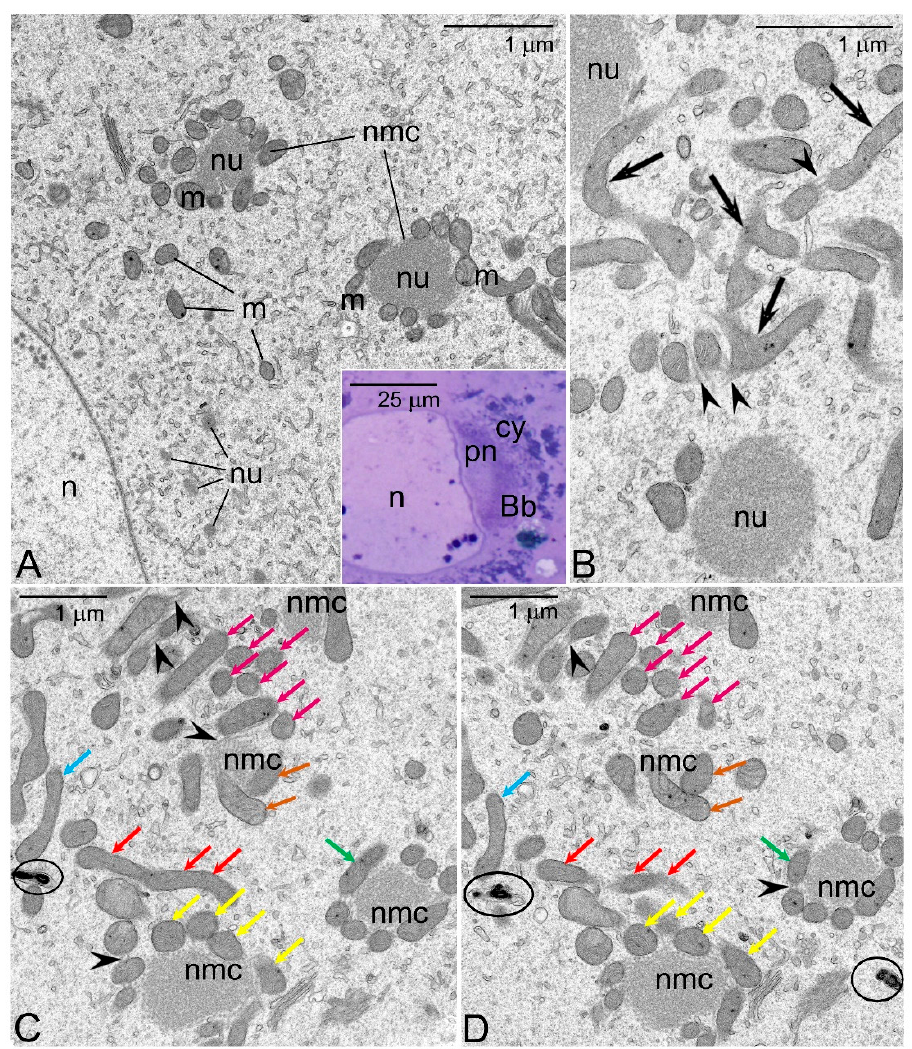
Figure 2. Balbiani body (Bb) of Metrioptera brachyptera . ( A ) and ( insert ) The Bb consists of two zones: perinuclear (pn) and cytoplasmic (cy). Note mitochondria (m), nuage accumulations (nu) and nuage/mitochondria complexes (nmc). Oocyte nucleus (n). TEM; ( insert ) semi-thin section stained with methylene blue. ( B ) Elongated and bifurcated mitochondria (arrows) in contact with nuage accumulations (nu) and nuage filaments (arrowheads). TEM. ( C , D ) Serial sections through four closely positioned nuage/mitochondria complexes (nmc). Small arrows (in various colors) indicate corresponding mitochondrial profiles, arrowheads point to nuage filaments, mitochondria displaying signs of degeneration are encircled. TEM.